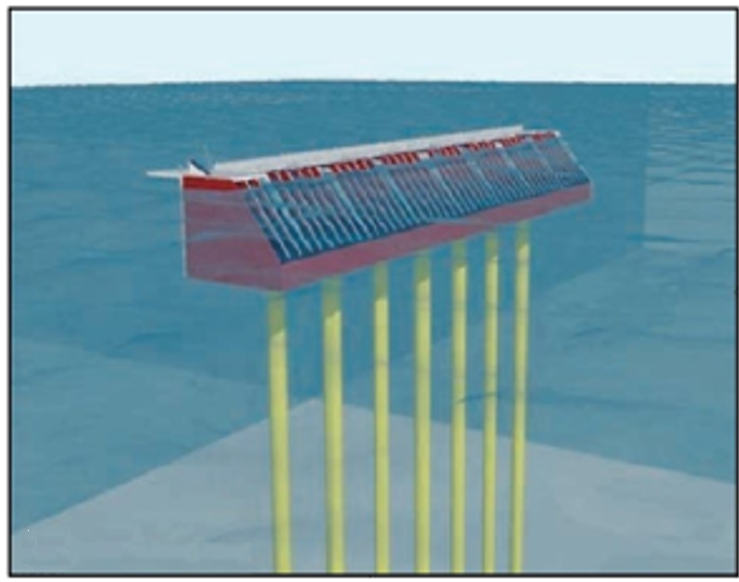
Figure 3. Diagram of the WEBAP (Wave-Energized Aeration Pump) device [28].